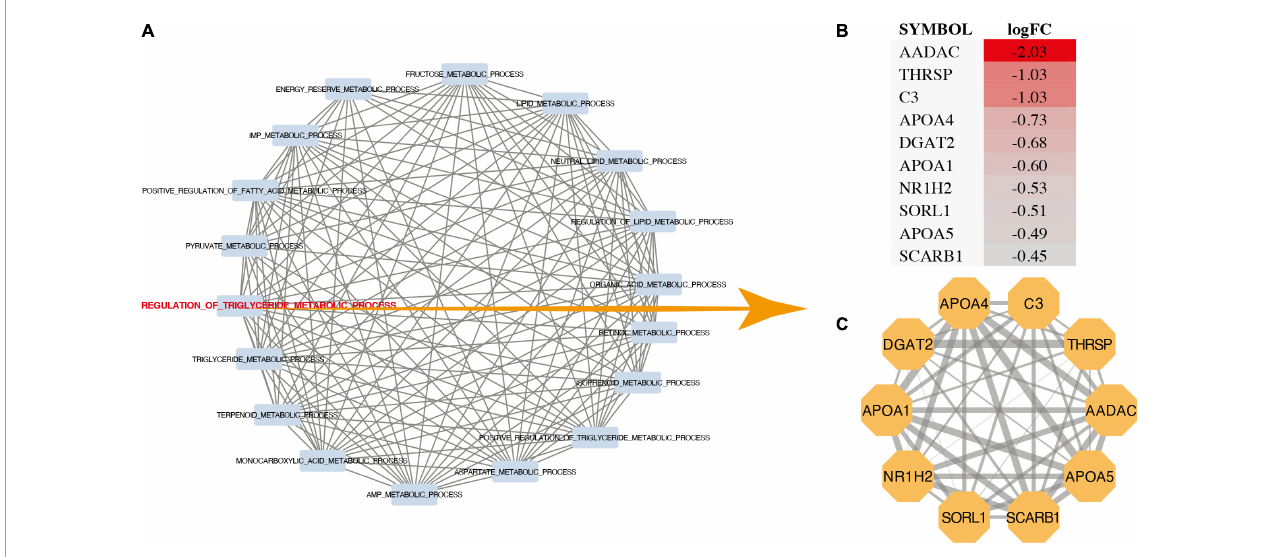
FIGURE3 Pathway interaction analysis. (A) Pathway interworking network. (B) LogFC of genes in regulation of triglyceride metabolic process. (C) Protein-protein interaction network of genes in regulation of triglyceride metabolic process.